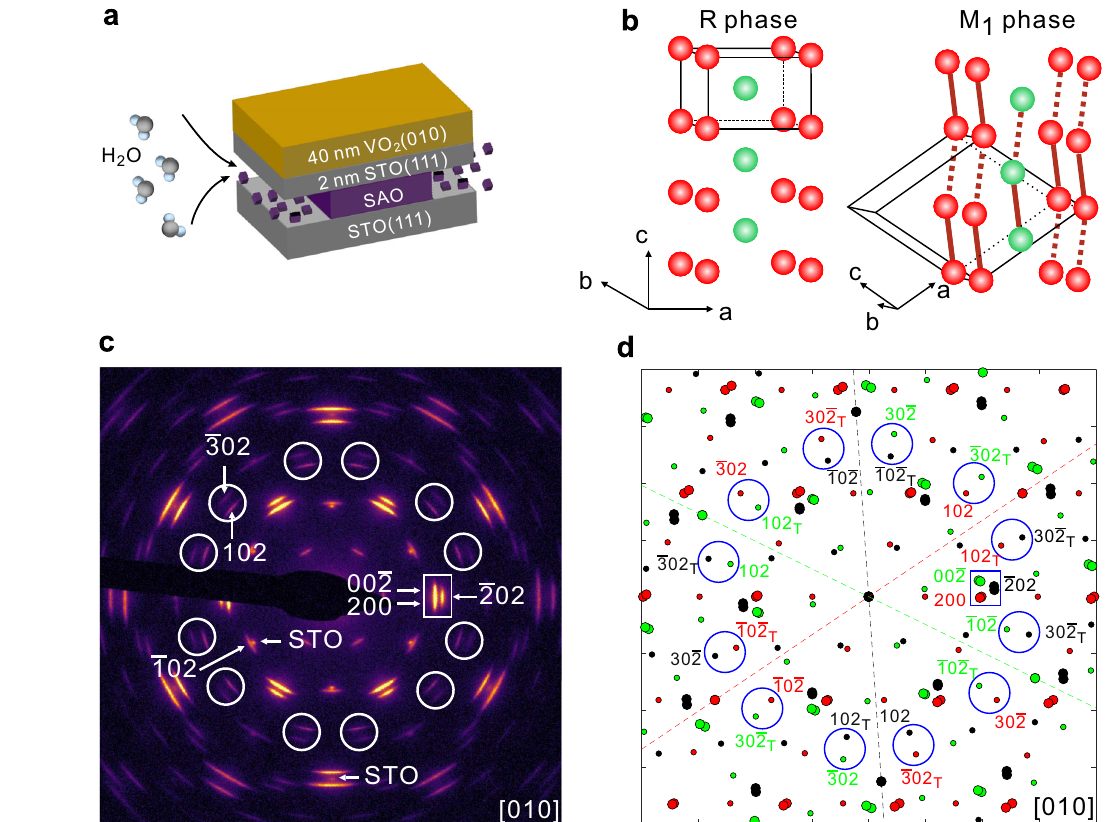
Fig. 1 | Static electrondiffractions ofVO 2 by TEM. a Schematic layout of the VO 2 electrondiffractionpatternmeasuredat300KbyTEM.Theincidentelectronbeam fi lms for UED experiments. STO represents SrTiO isalong[010]directionofVO 2 . d SimulatedTEMdiffractionpatternintheM 1 phase 3 (111) which is used as substrate andbufferlayer.SAOrepresentsSr 3 Al 2 O 6 whichisusedassacri fi ciallayer.SAOcan with three domains and twinning. Red/green/black colors represent the contribu- tions from three 120° domains, respectively. For convenience, we use smaller dots be etched by water indicated by black arrows. b Crystal structures of VO 2 in the R topresentthesuperstructurespots.Thesubscript “ T ” meansthecontributionfrom phase and M 1 phase. Only V atoms are presented. Red solid lines in the M 1 phase represent V – V dimers. Hexahedrons with black lines are the unit cells. c Static a twin